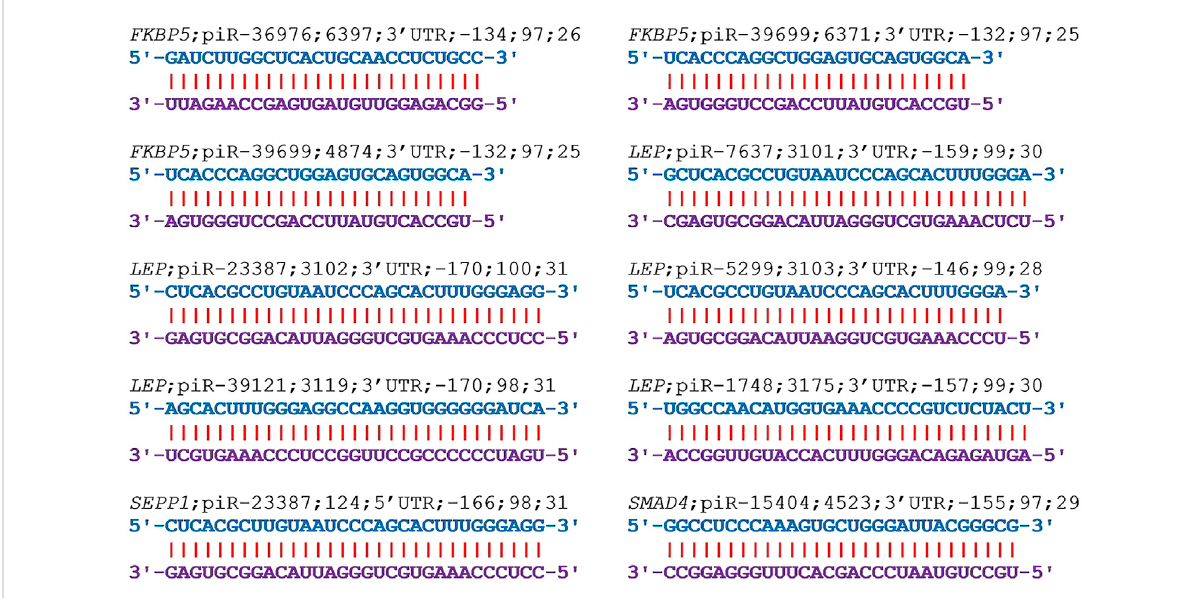
FIGURE 2 The schemes of interaction between piRNAs and mRNAs of EAC candidate genes with Δ G/ Δ Gm) values greater than 97% or more.